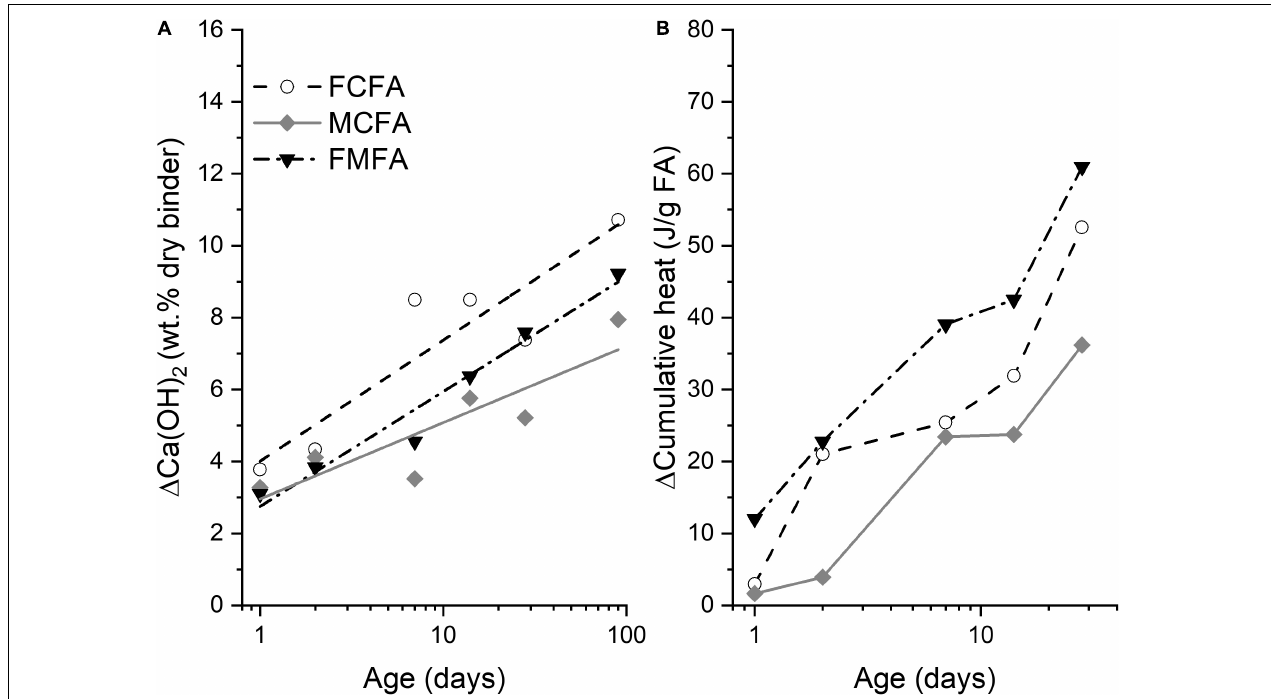
FIGURE 10 | Indirect indicators of fly ash reactivity in blended cements. (A) Consumption of portlandite with indicative linear trendlines, (B) additional heat release for the fly ashes.